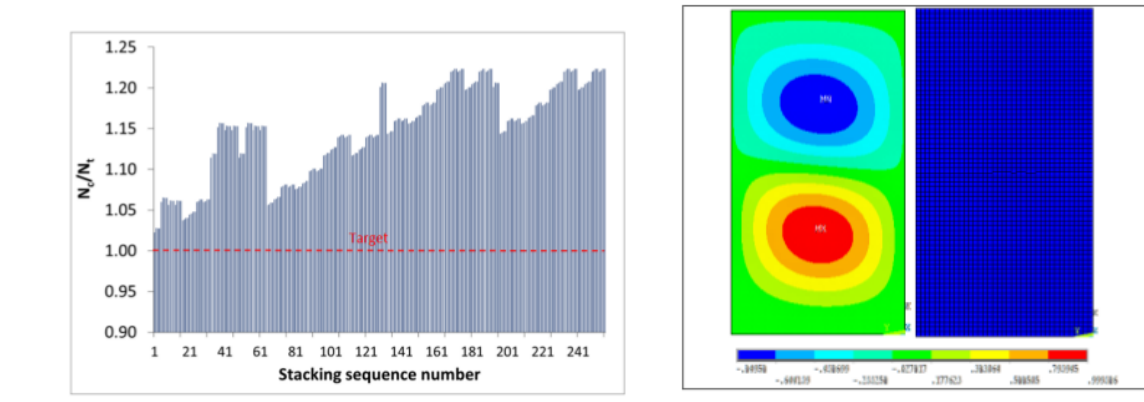
Figure 8: Ratio of N C / N t for all possible combinations of stacking sequence of symmetric UD laminates made of 8 layers from 4 op- tions according to Table 3. Set target buckling load is 200N/mm. All passed.